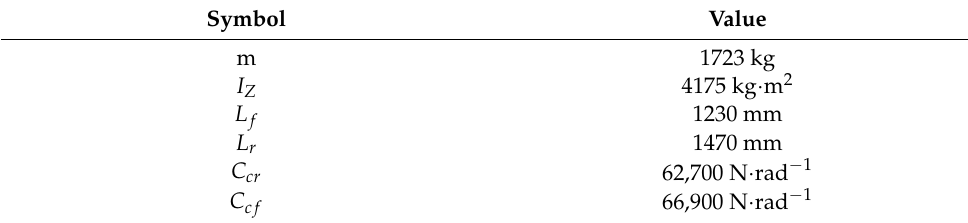
Table 2. Parameters of the vehicle